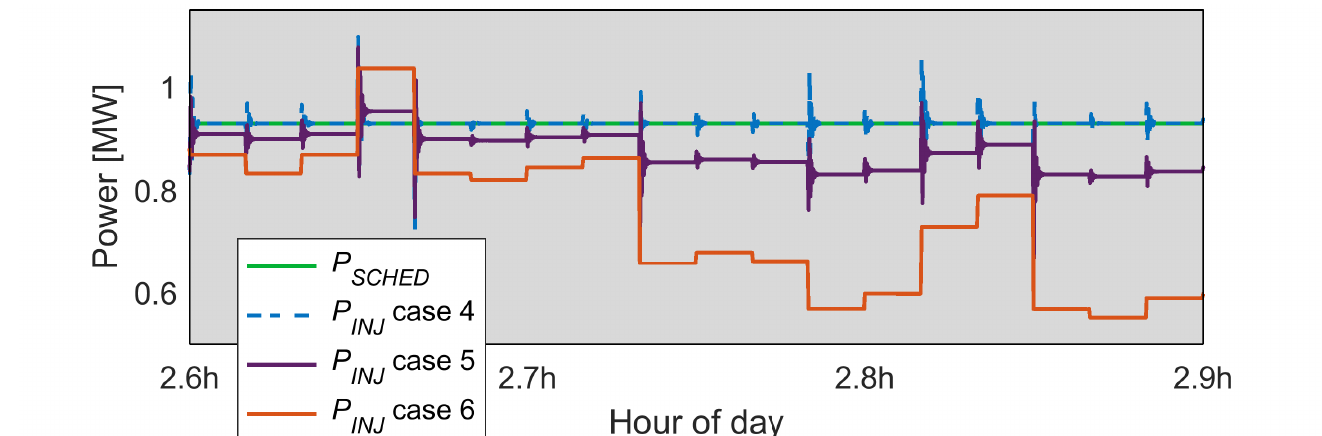
Figure 27. Scenario 2: Injected power and tolerated band/injection region.